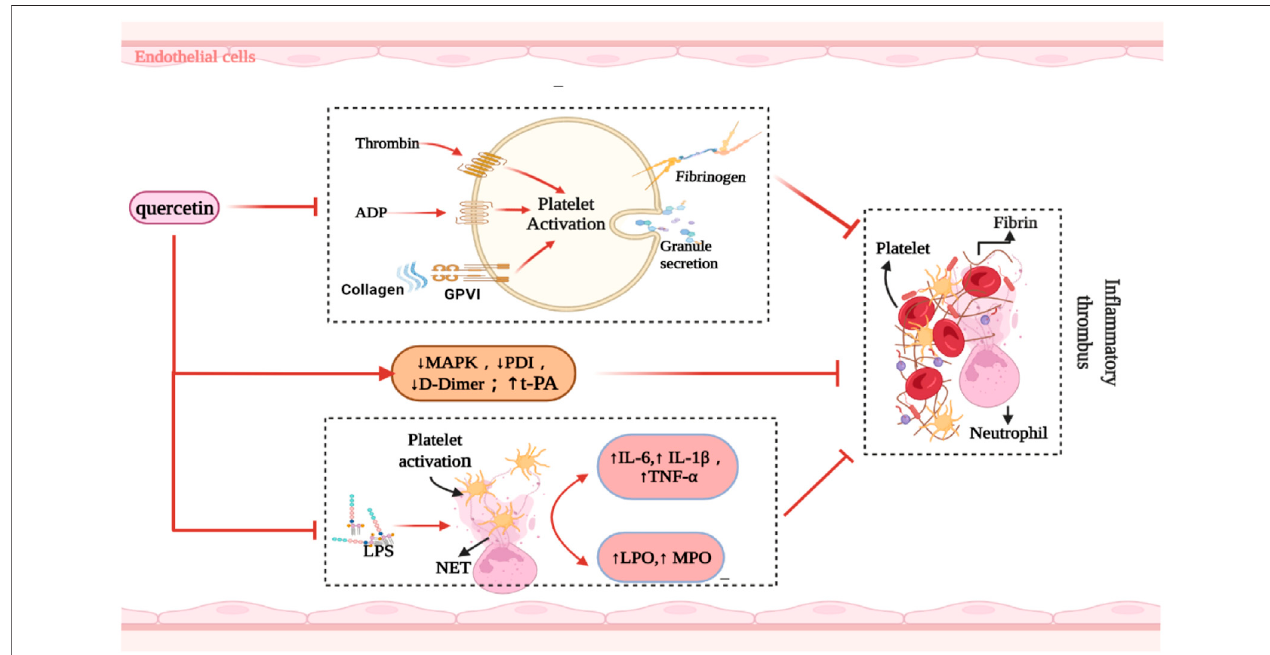
FIGURE 2 | Summarized the mechanism of quercetin inhibiting in fl ammatory thrombosis. Abbreviations: ↑ , increase; ↓ , decrease; ADP, Adenosine diphosphate; PDI, Protein disul fi de isomerase; NET, neutrophil extracellular trap; LPO, lipid peroxidation; MPO, myeloperoxidase; t-PA, anti-tissue-plasminogen activator; MAPK, mitogen-activated protein kinase; LPS, lipopolysaccharide; GPVI, glycoprotein VI; IL, interleukin; TNF- α , tumor necrosis